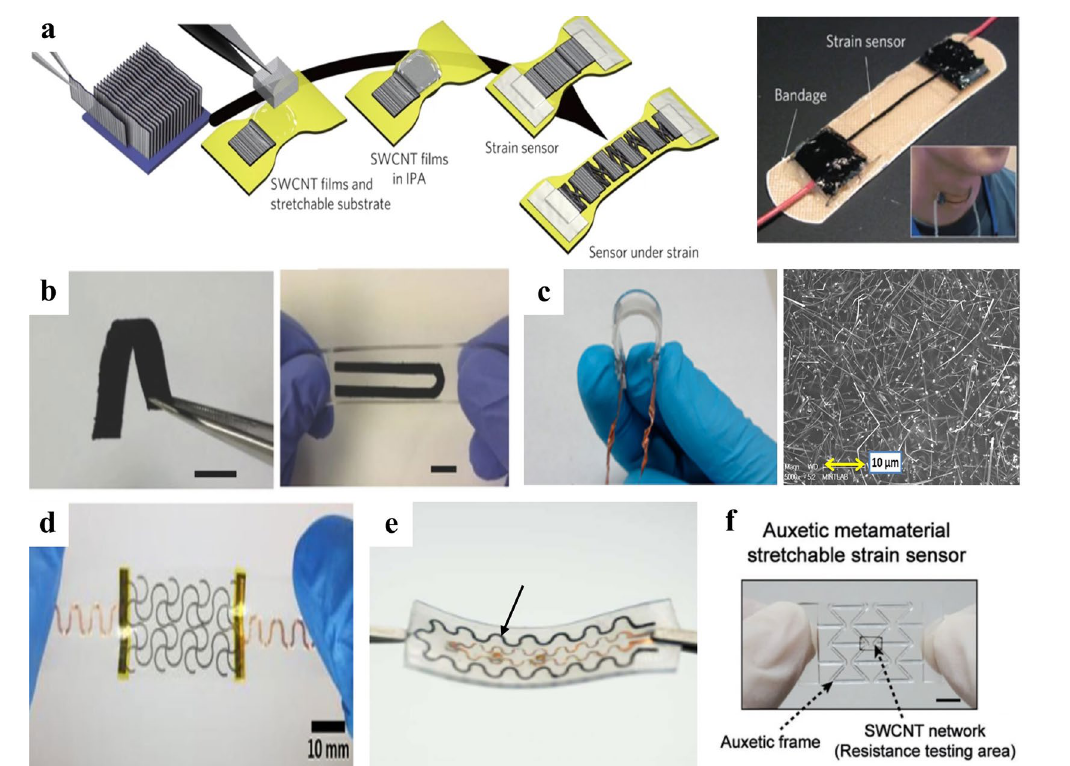
Fig. 5 Typical design strategies of flexible strain sensors. a Thin films of aligned single-walled carbon nanotubes (SWCNT) [54]. Copyright (2011) Springer Nature. b Thin films of graphene-nanocellulose composites [122]. Copyright (2013) Wiley–VCH. c Transparent films of sand- wich-structured PDMS/AgNW/PDMS nanocomposites [123]. Copyright (2014) American Chemical Society. d A serpentine layout of PVDF [124]. Copyright (2019) American Chemical Society. e A serpentine layout of hollow Ag-microspheres/carbon nanoparticles/Eco-flex compos- ites [37]. Copyright (2022) Elsevier. f Auxetic metamaterial structures regulated SWCNT network on PDMS thin film [125]. Copyright (2018)